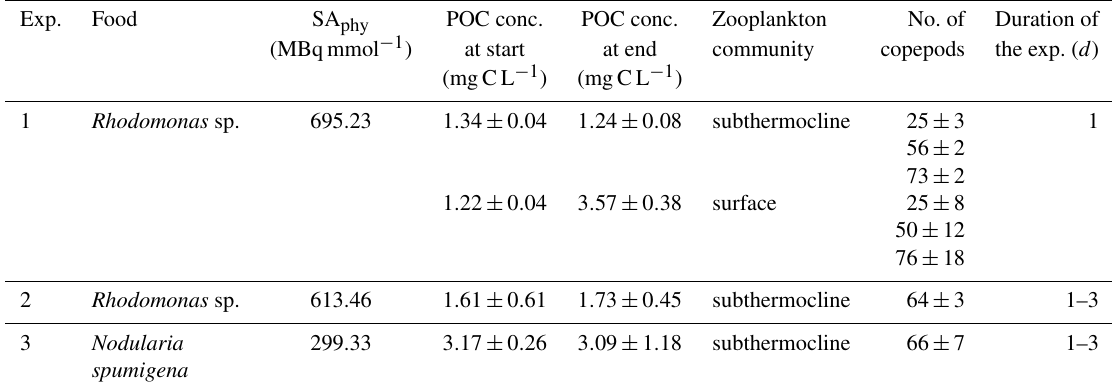
Table 1. Experimental conditions for the zooplankton grazing experiments (exp.). SA phy is the specific activity of the phytoplankton fed to the copepods. POC stands for particulate organic carbon. No. of copepods is the average amount of copepods used in the incubation